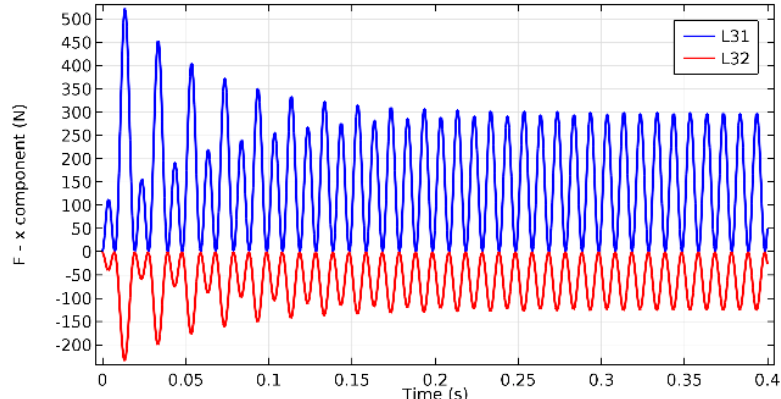
Figure 13. Electrodynamic forces on earthing knifes L31 and L32 obtained by FEM calculation.